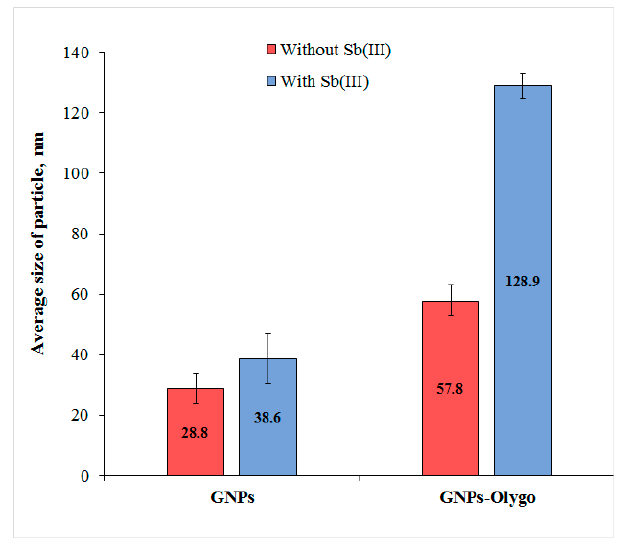
Figure 3. Results of dynamic light scattering (DLS) characterization of native and PAO-modified gold nanoparticles in absence and presence of antimony at 10 ng/mL in the solutions (n = 3).